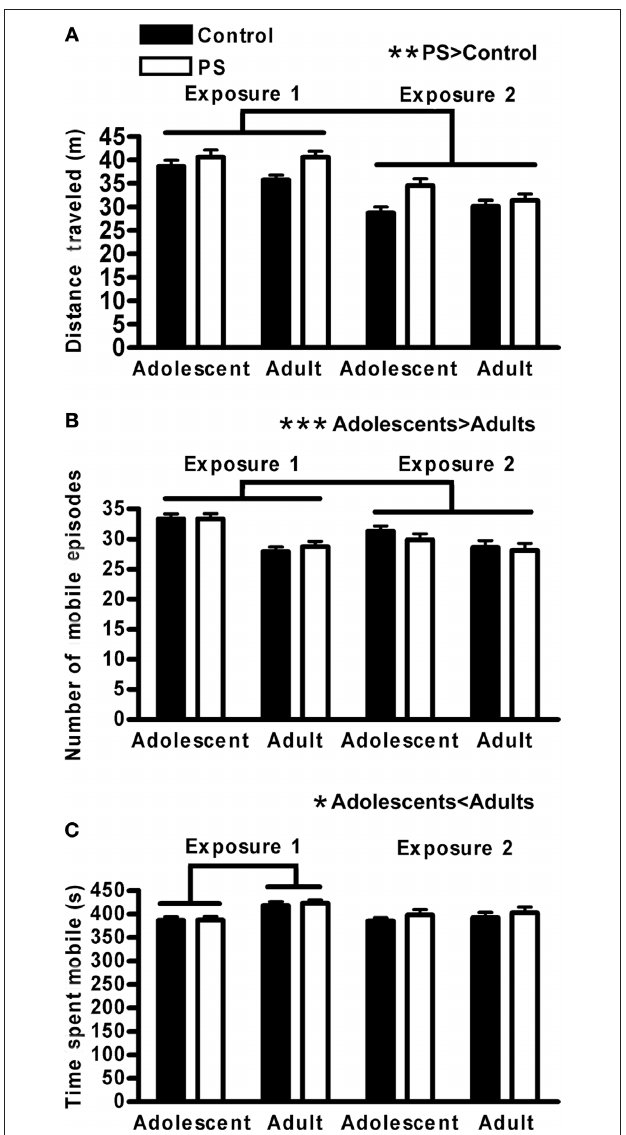
Figure 1 | Locomotor activity during open field habituation for the novel object recognition task. (A) Distance traveled decreased with multiple exposures to the open field/testing apparatus ( p < 0.01 × 10 − 16 ), and prenatally stressed (PS) animals were more active than controls (** p < 0.01). (B) Adolescents engaged in more mobile episodes than adults (*** p < 0.00001), but (C) spent less time mobile overall (* p < 0.02), especially on the first exposure (age × exposure interaction, p < 0.01; adolescents < adults on exposure 1, ( p < 0.0001) indicating shorter but more frequent bouts of activity for younger animals. Males and females did not differ on any measure of locomotor activity. Lines above graphs indicate significant group differences. Values are group mean ±